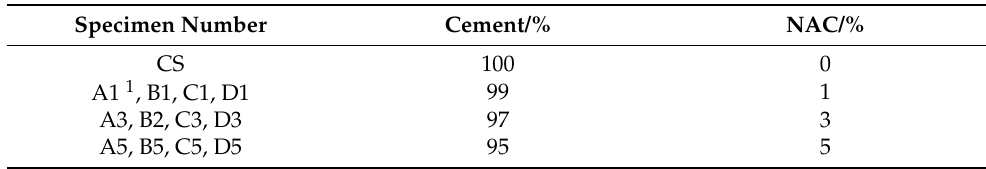
Table 3. Mixing proportion of cement paste with NAC (raw ore and high-viscosity ore) under different activation